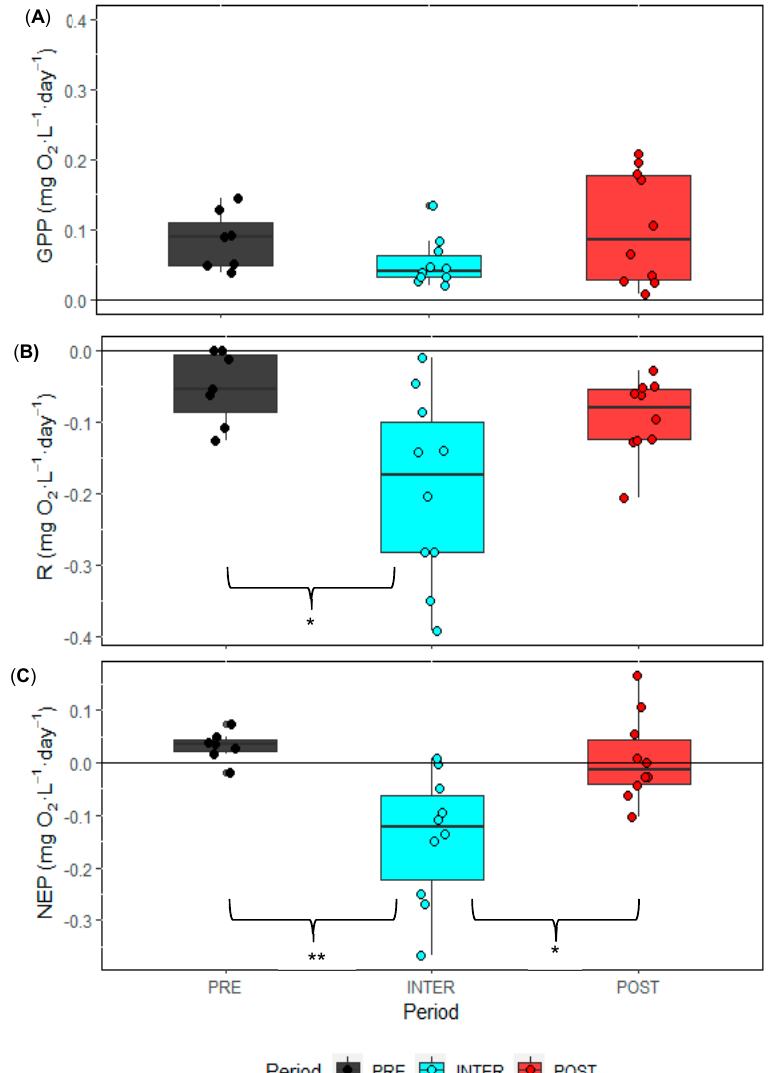
Figure 4. Daily averages of epilimnetic (0.9 m) metabolism estimates (mg O 2 · L − 1 · day − 1 ) of ( A ) gross primary productivity (GPP), ( B ) respiration (R), and ( C ) net ecosystem productivity (NEP) in Lough Feeagh during the periods pre- (black points n = 7), intermediate (blue points n = 10) and post- (red points n = 10) Storm Hector. In each boxplot, the black line is the median and the box represents the 25th and 75th percentiles. The upper and lower whiskers represent values outside the middle 50%. Values that lie outside the observed distribution are represented as points above or below the respective whiskers. Statistical significances following pairwise multiple-comparison Dunn’s test for determining differences between periods on metabolic estimates are indicated with curly brackets where p -values < 0.05 are represented with ‘*’, and p -values < 0.01 with ‘**’.